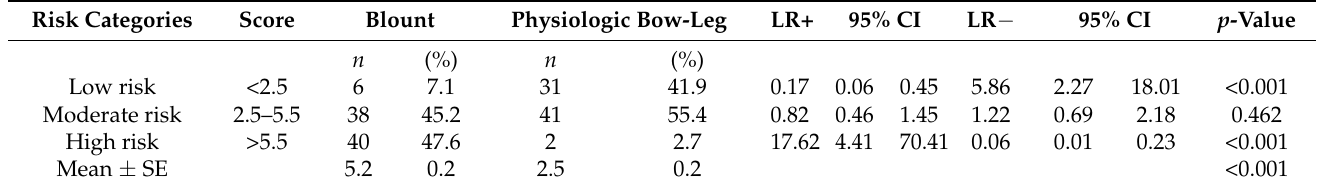
Table 5. Distribution of Blount’s disease and physiologic bow-leg into low, moderate, and high-risk categories with model scoring, positive likelihood ratio (LR+), and negative likelihood ratio (LR − ) with their 95% confidence intervals